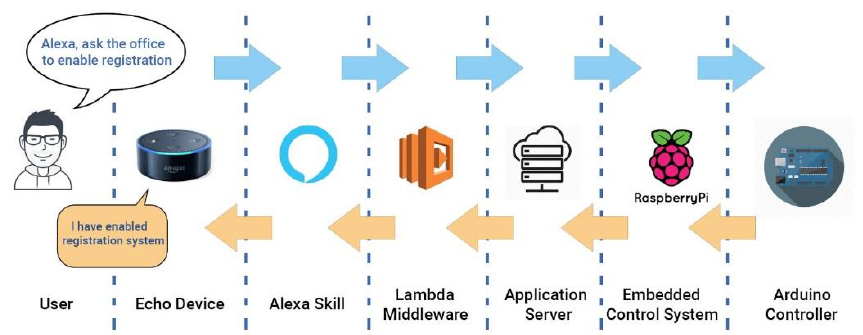
Figure 7. Life cycle of Alexa interaction.